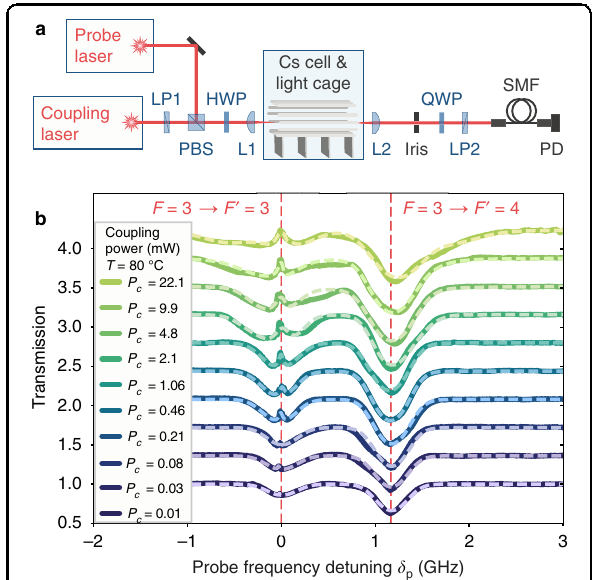
Fig. 2 EIT in the light cage (LC). a Setup for the optical experiments. The probe and coupling laser beams are jointly coupled into the LC (placed inside the temperature-controlled Cs vapour cell) with an aspheric lens (L1) and recollimated afterwards (L2). Polarisation optics are used to suppress the coupling laser (linear polarisers LP1, LP2; polarising beam splitter PBS; half- and quarter-wave plate HWP, QWP). An iris and single-mode fi bre (SMF) coupling ensure spatial fi ltering before detection on a photo diode (PD). b Broadening and additional absorbing shoulders near the EIT peak appear at high coupling laser powers. Dashed lines are fi tting